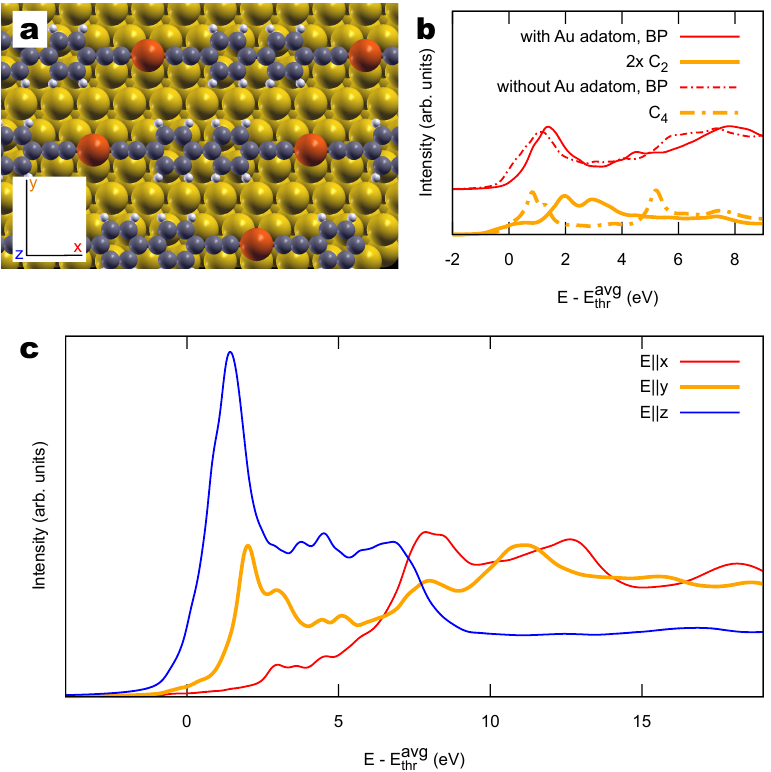
Figure 7. ( a ) Structural model of bBEBP/Au(111) embedding a Au adatom (red) in between two organic units. ( b ) Simulated polarization-averaged NEXAFS spectrum (solid) compared to the one of Figure 6a (without the Au adatom, dashed). ( c ) Polarization-resolved NEXAFS spectrum; see panel ( a ) for the definition of the x , y , z polarization